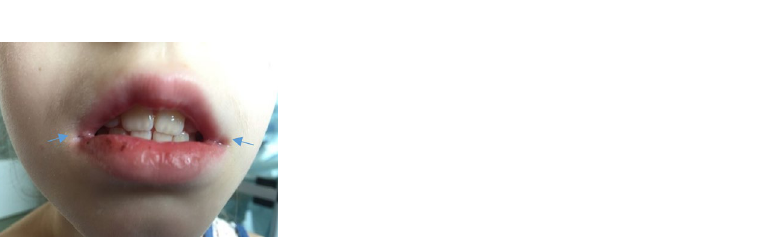
Figure 1. Aphthae in a child diagnosed with Crohn’s disease.